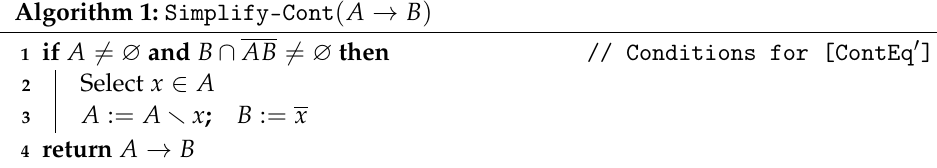
Algorithm 1: Simplify-Cont ( A